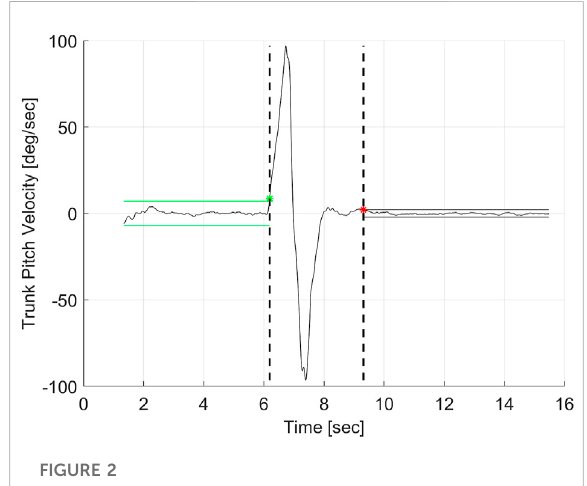
FIGURE 2 Schematic illustrating the calculation of the start and end of the sit-to-stand task based on the trunk pitch